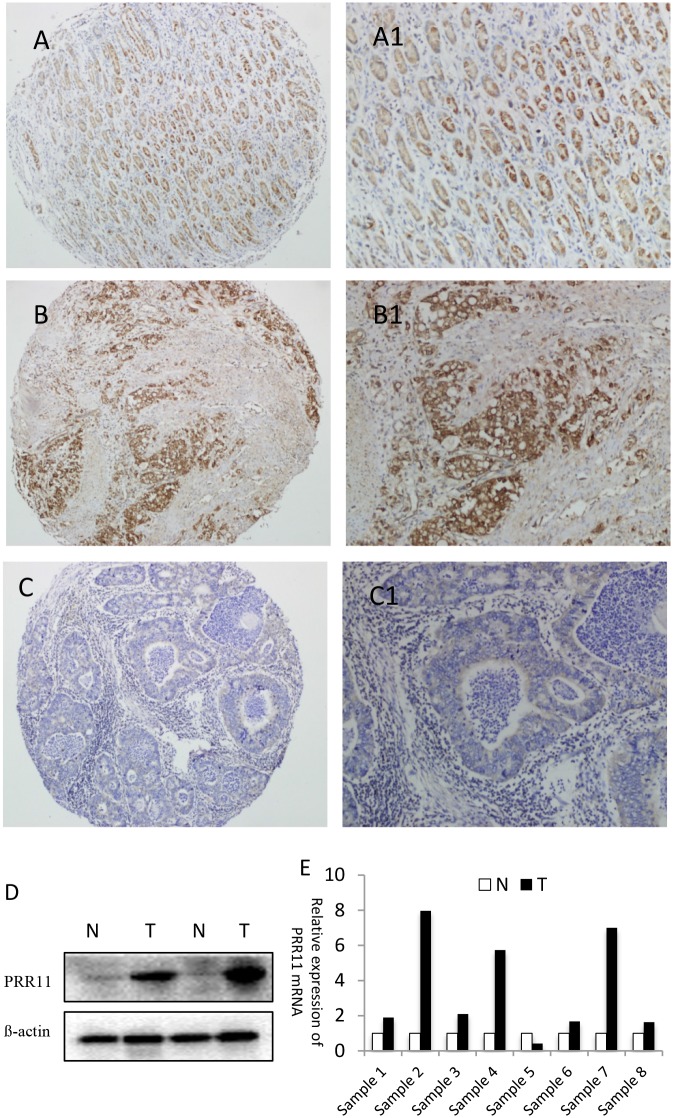
Analysis of PRR11 expression in human gastric cancers and adjacent normal mucosa specimens.(A, A1) Normal gastric mucosa showed weak staining of PRR11; (B, B1) Positive staining of PRR11 in gastric cancer; (C, C1) Negative staining of PRR11 in gastric cancer. A1, B1, C1 are enlargement of tissues from A, B, C, respectively. Original magnification of A, B, C: 40×; Original magnification of A1, B1, C1: 200×. (D) Western blotting revealed increased expression of PRR11 in tumor samples (T) compared with that in noncancerous tissues (N); (E) mRNA levels of PRR11 in gastric cancer tissues (T) and normal tissues (N).